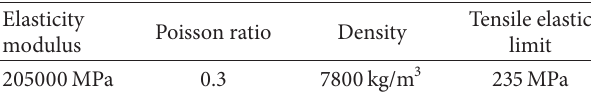
Figure 4: Microstructure of HAZ. Table 2: Mechanical properties of S235 steel.